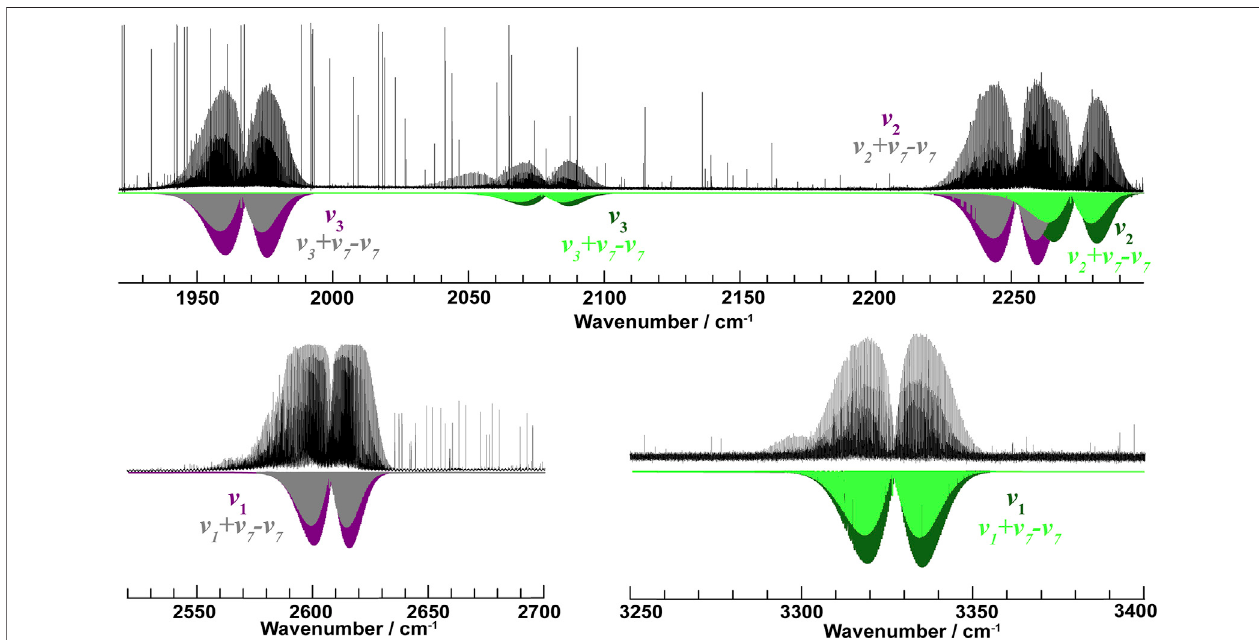
FIGURE1| PortionsoftherecordedMIRspectra(blacktraces):1,930 – 2,300 cm − 1 ,2,500 – 2,700 cm − 1 and3,250 – 3,400 cm − 1 .Spectralsimulationsbasedonthe spectroscopic constants of Tables 2 , 3 are reported for both DC 3 N (violet traces) and HC 3 N (green traces). Recording conditions: T (cid:2) 298 K, p (cid:2) 16 – 32 Pa (top and bottom-left: 32 Pa, bottom-right: 16 Pa), L opt (cid:2) 8 m, 140 – 200 scans, unapodized resolution 0.004 cm − 1 .